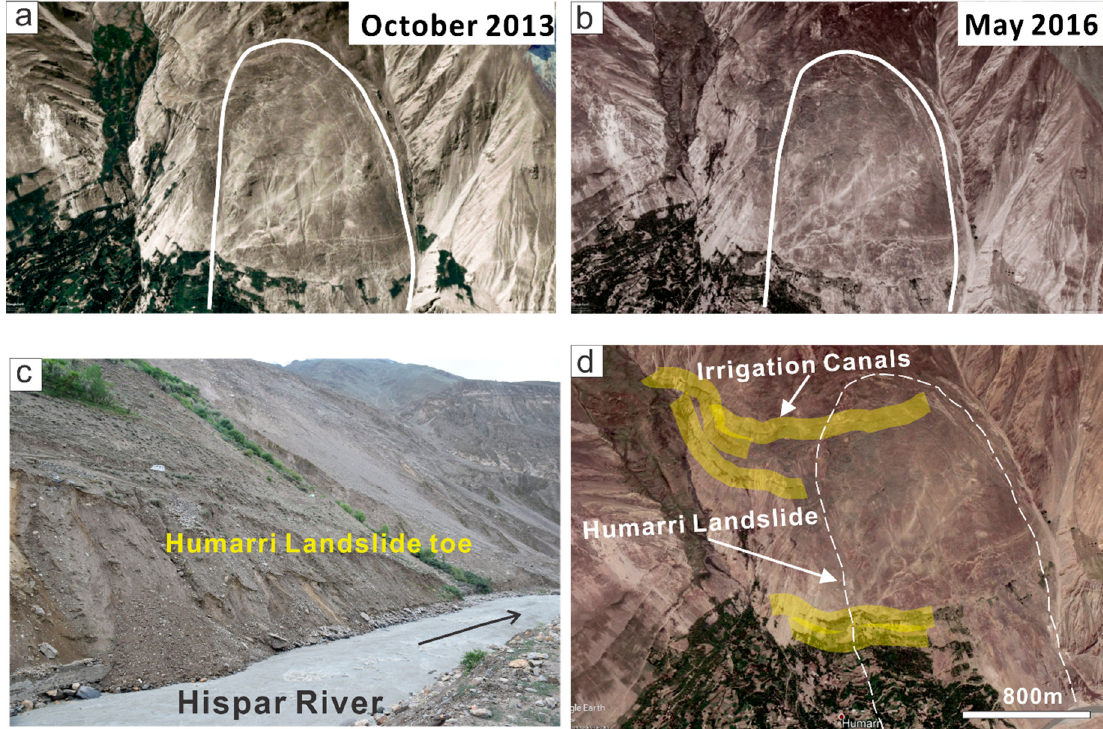
Figure 12. Satellite images of Humarri Landslide, ( a ) October 2013, ( b ) May 2016, ( c ) toe erosion of Humarri landslide due to the Hispar River, and ( d ) abandoned Irrigation canal in the upper part of Humarri landslide.